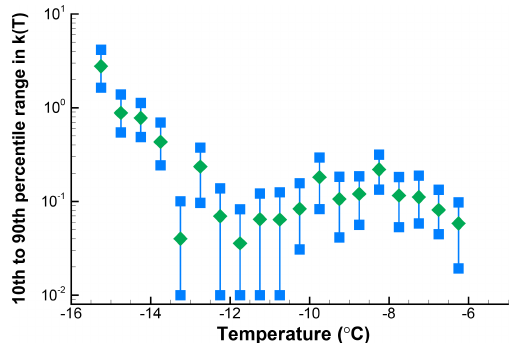
Figure 8. The 10th to 90th percentile range of k(T ) for the results shown in Fig. 7. The green diamonds show the values of k(T ) from the right-hand column of Table 3 for the observed sequence of freez- ing events. Points just above the abscissa are actually zero